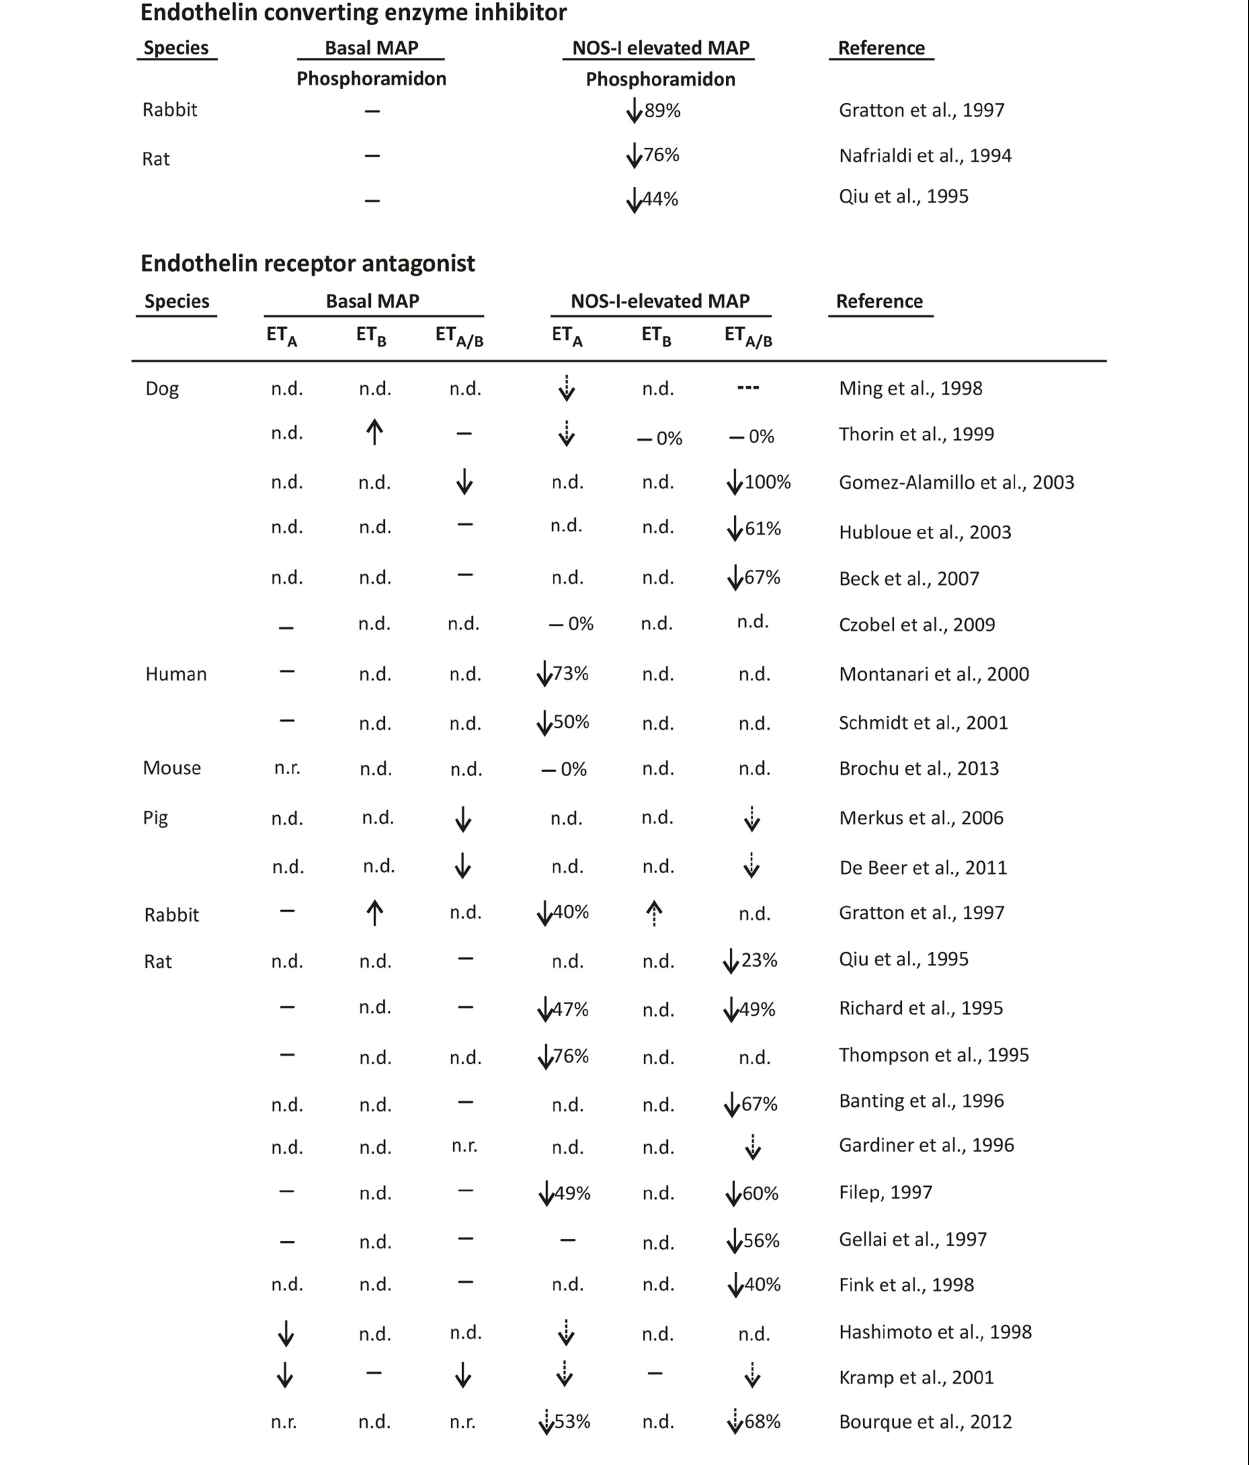
FIGURE 1 | Effects of ET converting enzyme inhibitor and ET receptor antagonist on basal and NOS inhibitor-elevated arterial pressure. MAP = mean arterial pressure and ET A , ET B , and ET A / B = ET type A, type B, and A plus B receptor antagonists, respectively. ↑ , ↓ , -, n.d., and n.r. signify increased, decreased, no change, not determined, and not reported, respectively. Dashed arrow